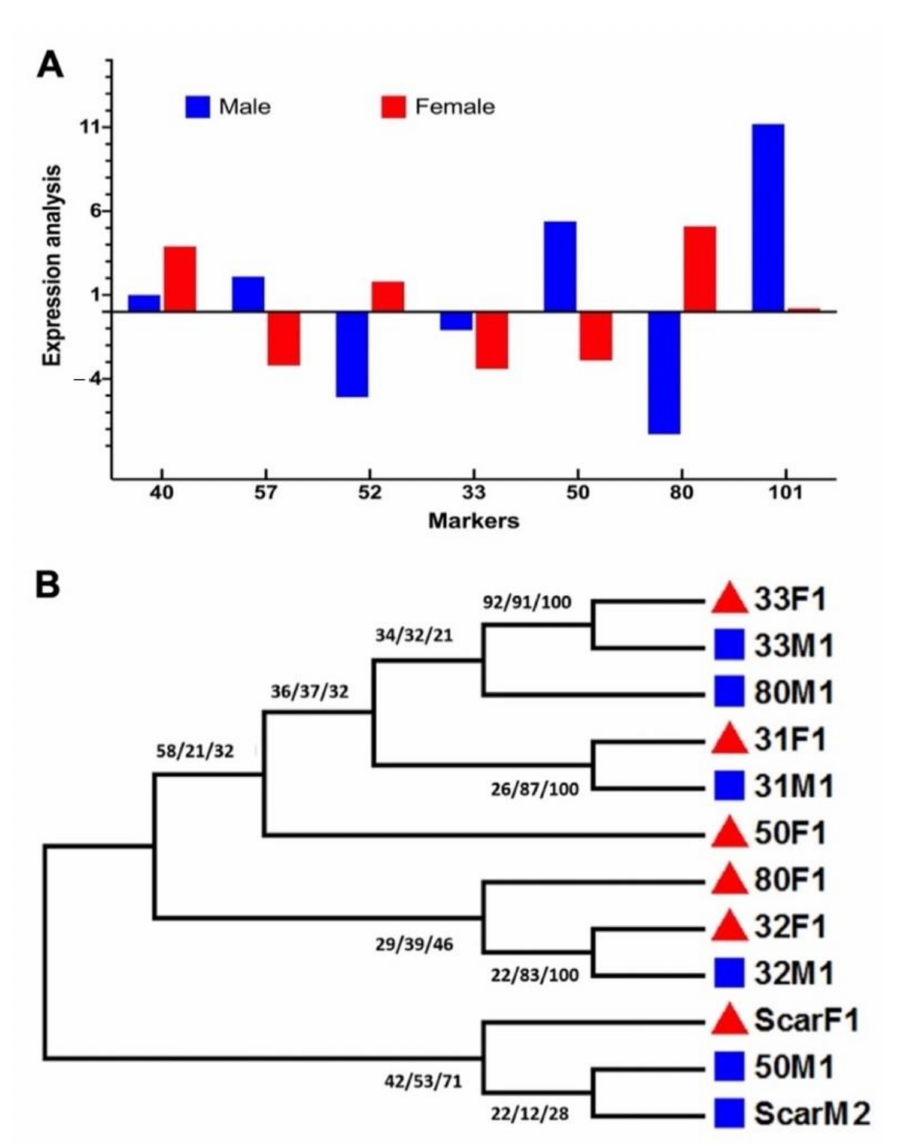
Figure 6. Molecular analysis of markers related sex differentiation in immature leaf samples of date palm. ( A ) Gene expression and transcript accumulation related to sex-linked differentiation in male and female date palms. The up and down bars also represent up or down expression of a specific gene. ( B ) Detailed phylogenetic analysis using maximum parsimony (MP), maximum probability (ML), and neighbor-joining (NJ) methods with 1k bootstrapping and clade formation among male and female samples using specific loci to differentiate between the two sexes in date palms. Bars represent the means ± SE ( n = 3). MA/FA = actin control; F = female; M =